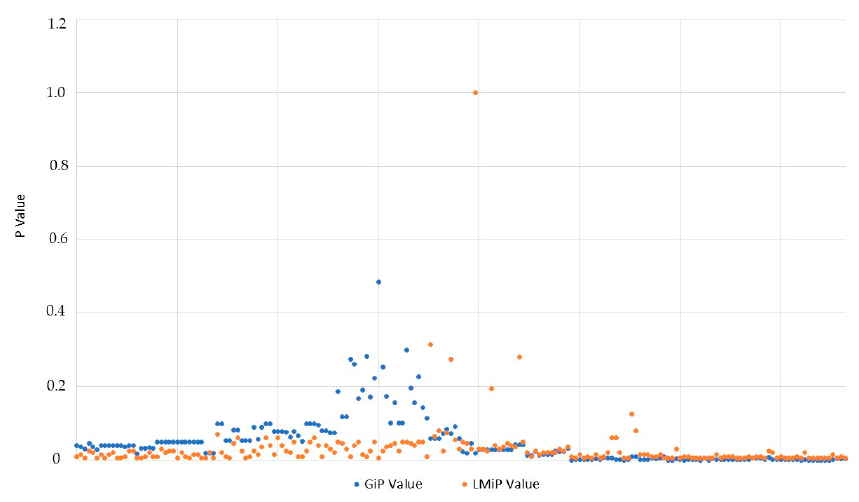
Figure 10. Results obtained with GiP Value and LMiP Value.